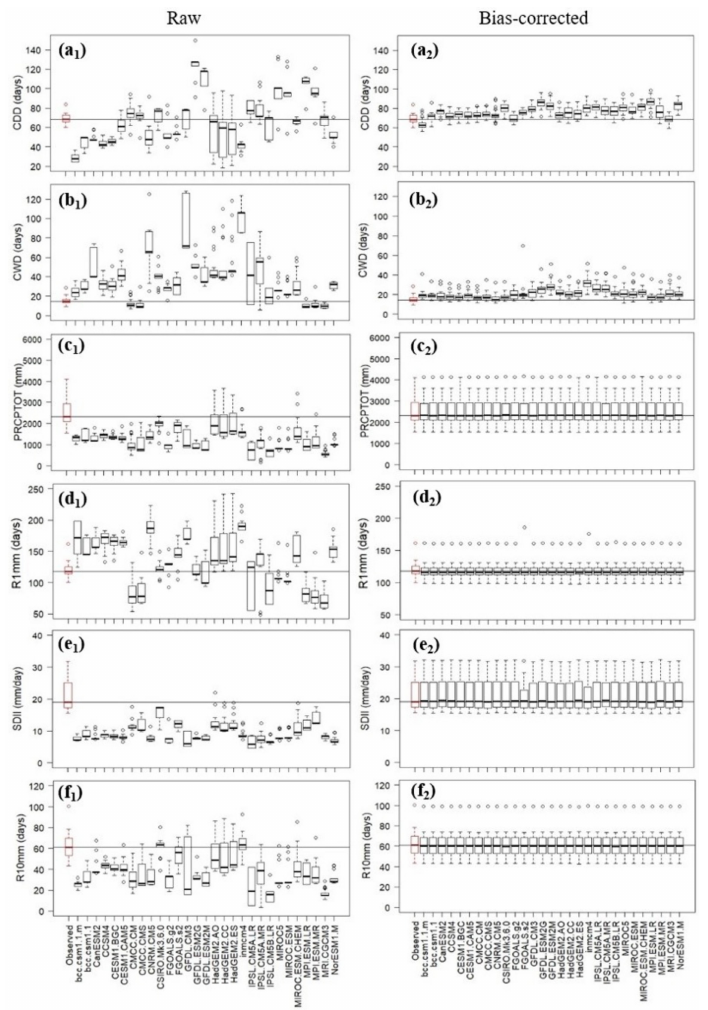
Figure 4. Comparison of raw (left) and bias-corrected (right) reproducibility with observed data for all meteorological stations in terms of the ( a ) CDD, ( b ) CWD, ( c ) PRCPTOT, ( d ) R1mm, ( e ) SDII, and ( f )